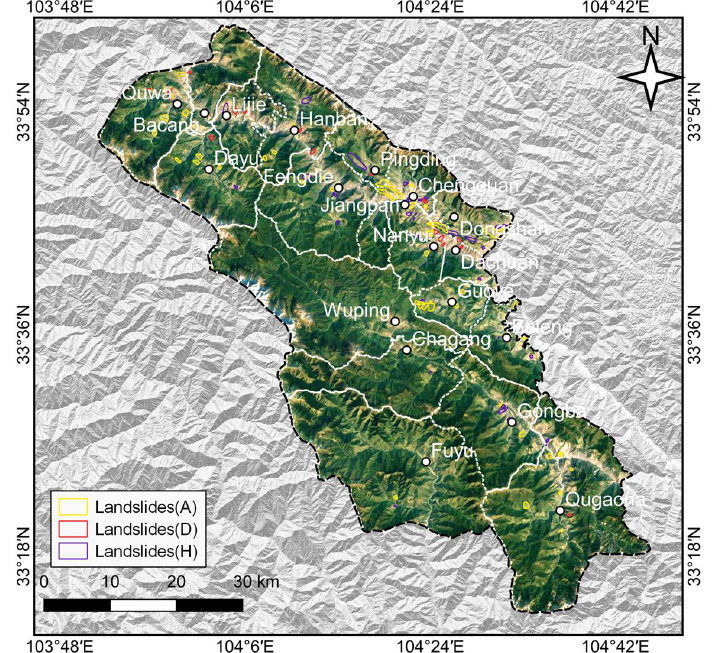
Figure 6. Landslide inventory map.